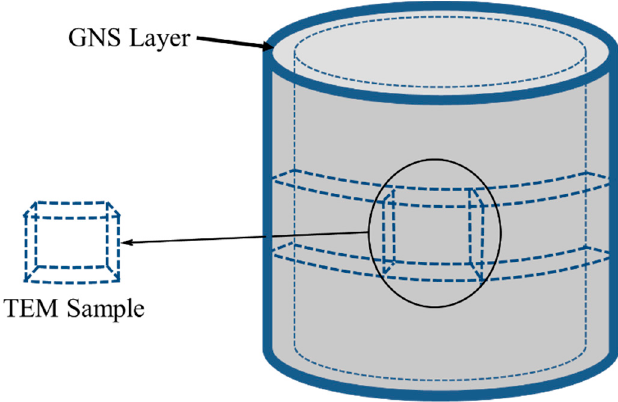
Figure 1. Schematic diagram of TEM sample preparation.